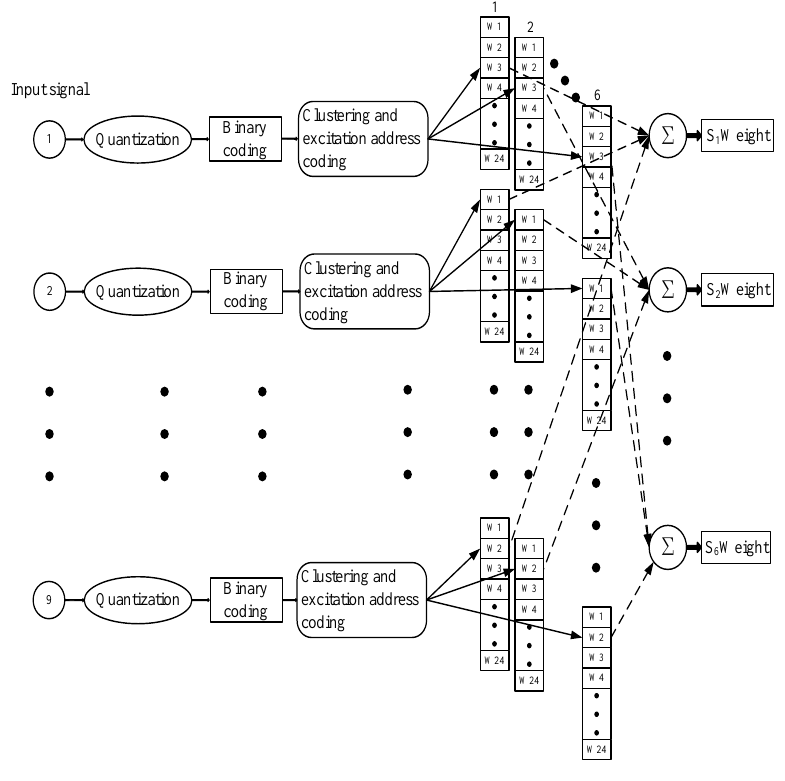
Figure 10. CMAC framework.